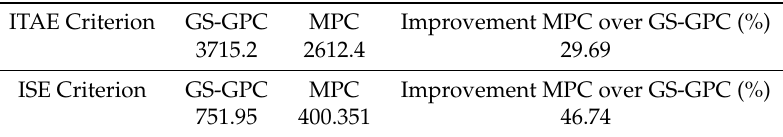
Table 2. Simulation 1: Performance comparison using ITAE and ISE criteria for the comparison between the GS-GPC and the MPC.